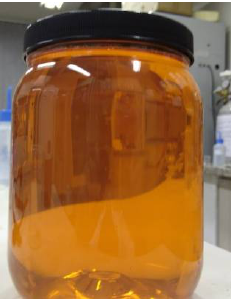
Figure 9. Cylindrical vial (20 cm tall and 15 cm in diameter) filled with FXO-f to perform 3D